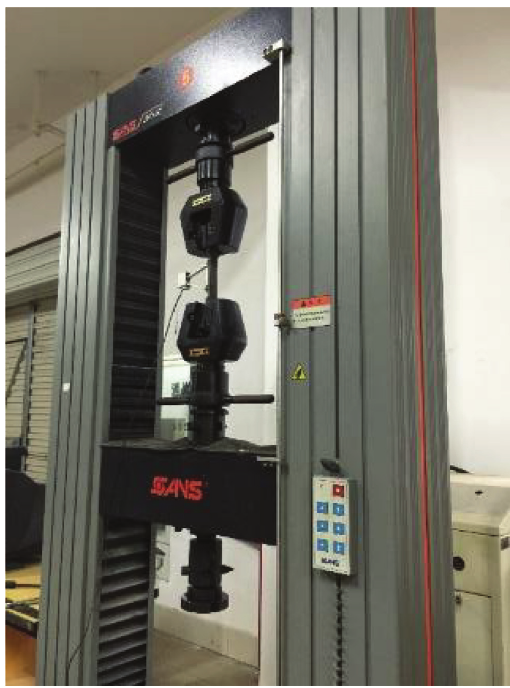
Figure 2: Universal material testing machine.